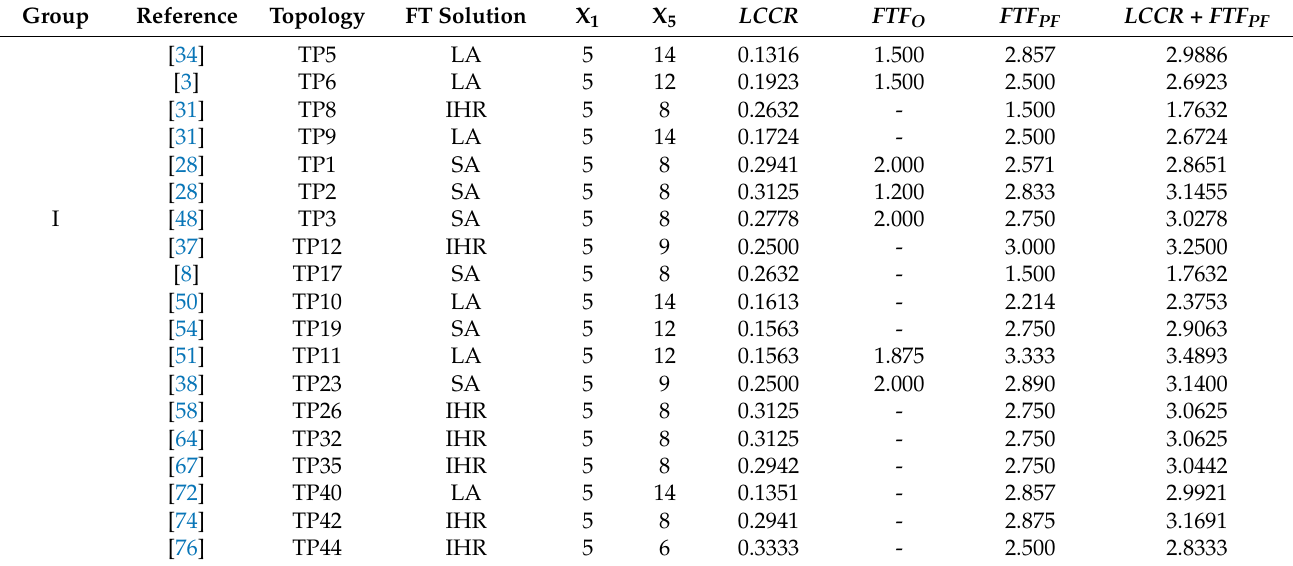
Table 5. Comparison of single-phase five-level FT MLIs for SSOC faults ( TSV is not